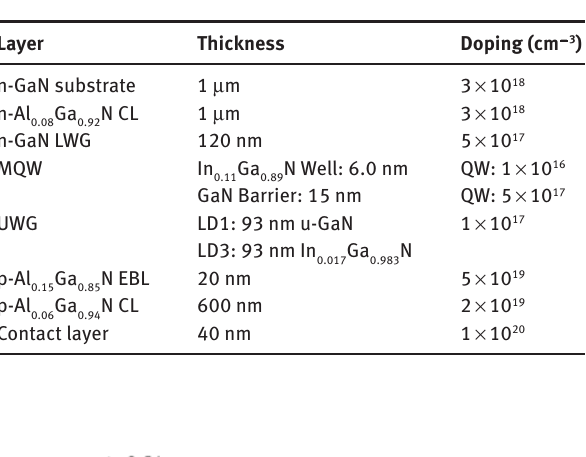
Table 1: Structural parameters of LD1 and LD3 for calculation with LASTIP.